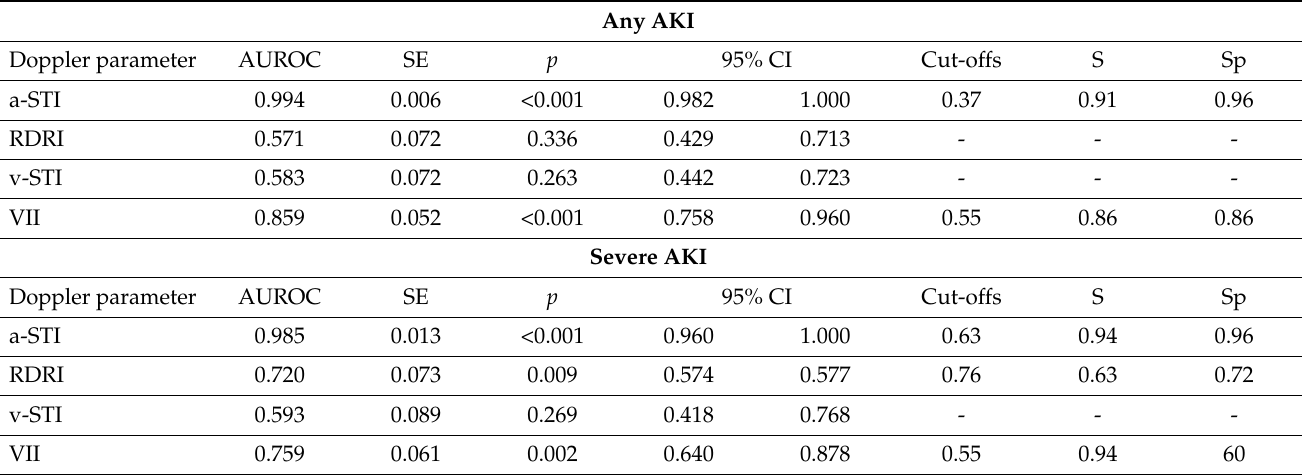
Table 3. ROC curves related to any or severe acute kidney injury within the day 5 after ICU admission for each Doppler parameter evaluated in this